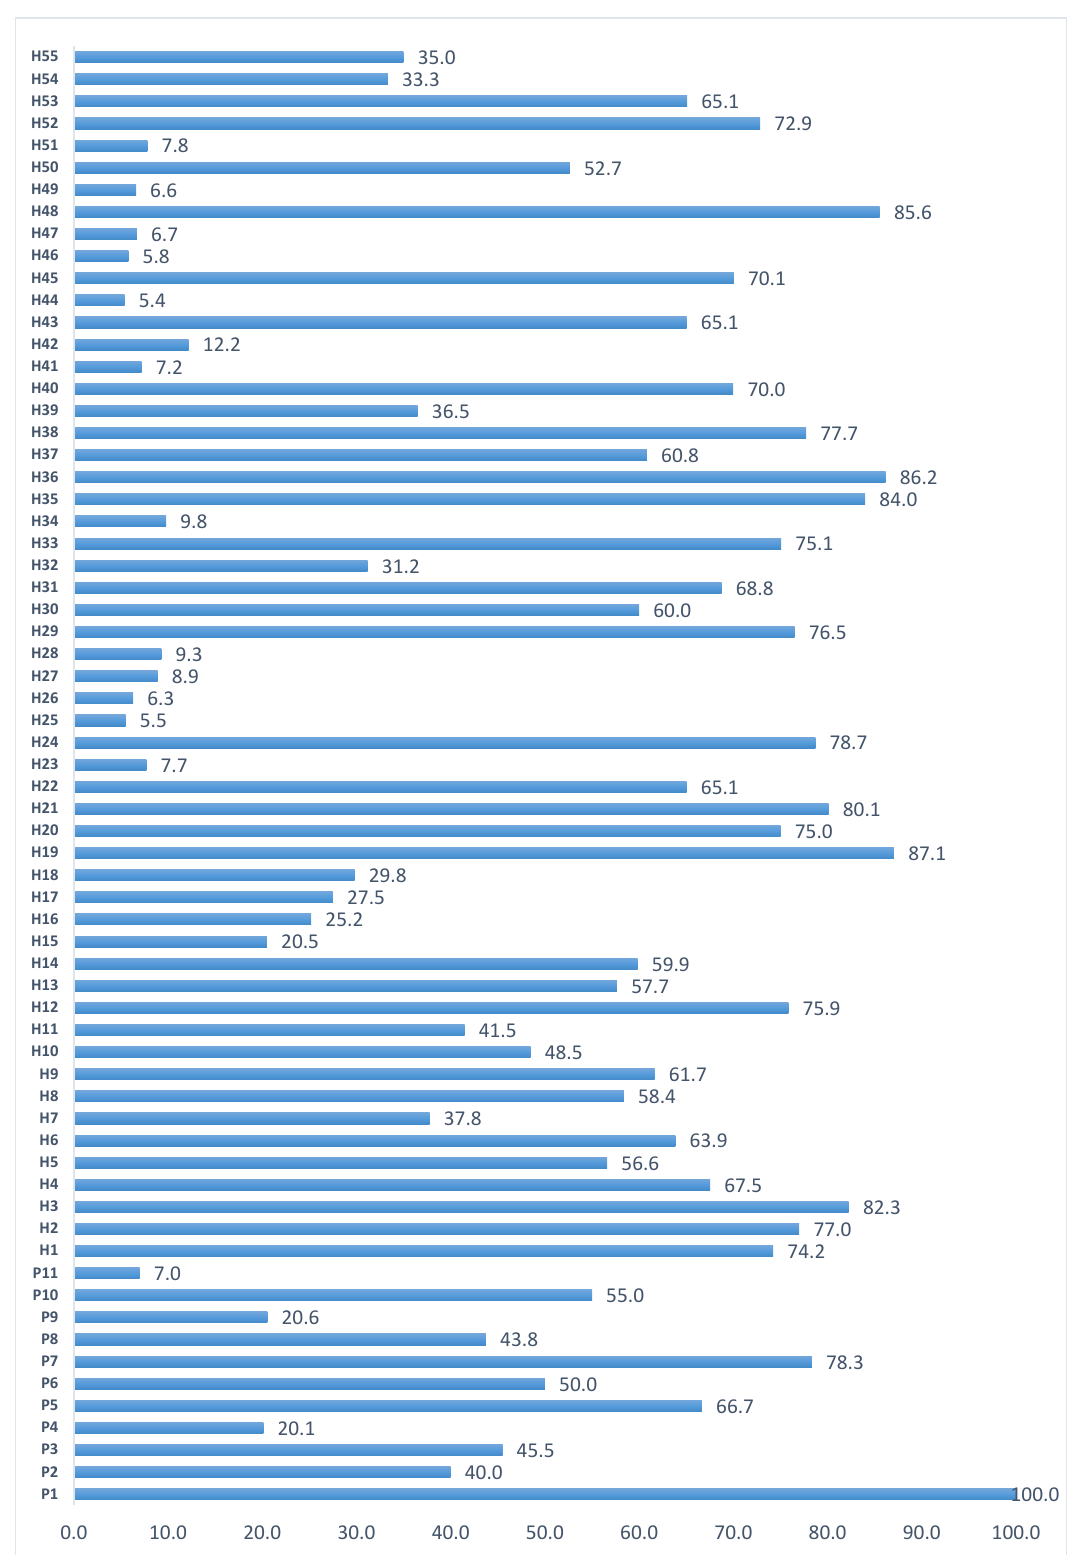
Figure 2. The percent disease incidence (PDI) reaction of parents and the hybrid cross combinations to TLCV infestation under field conditions.